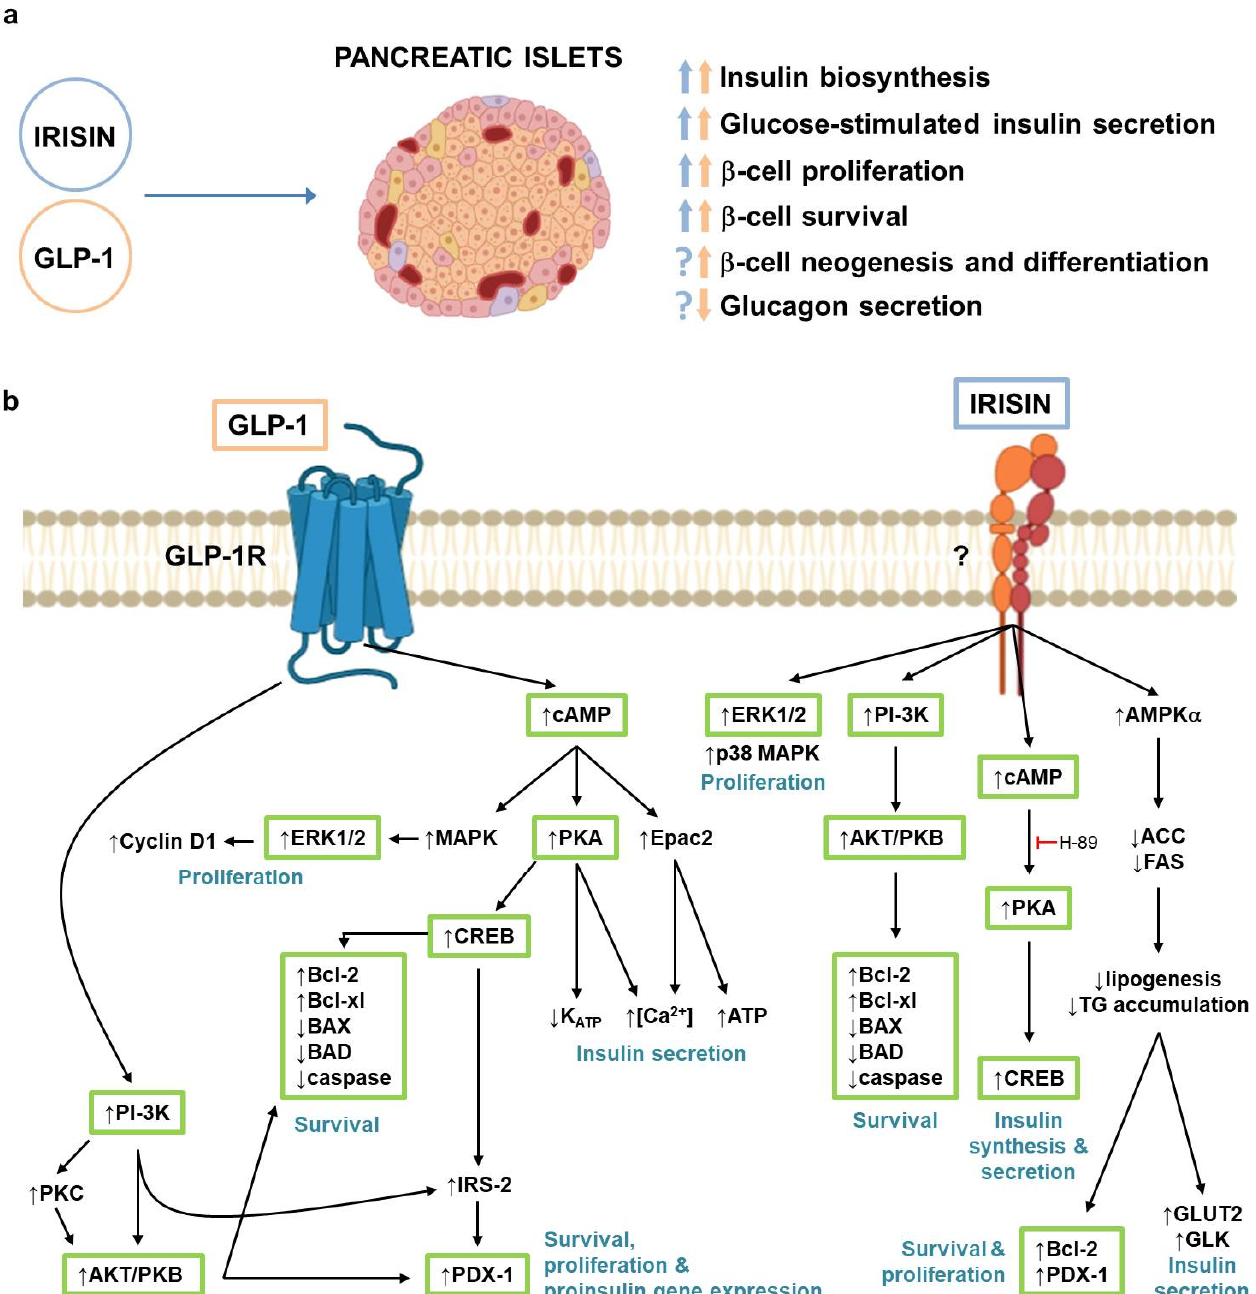
Figure 3. ( a ) GLP-1 and irisin effects in pancreatic islets. Blue arrows indicate irisin effects; orange arrows indicate GLP-1 effects; ( b ) Signaling pathways activated by GLP-1 and irisin in pancreatic β -cells. Green boxes indicate intracellular mediators activated by both GLP-1 and irisin. ACC, Acetyl-CoA carboxylase; AMPK α , adenosine monophosphate-activated protein kinase α ; AKT/PKB, protein kinase B; BAD, Bcl-2 associated agonist of cell death; BAX, Bcl-2-like protein 4; Bcl-2, B-cell lymphoma-2; Bcl-xl, B-cell lymphoma-xl; cAMP, cyclic adenosine monophosphate; CREB, cAMP response element-binding protein; Epac2, exchange protein activated by cAMP 2; ERK1/2, extracellular signal-regulated kinases 1/2; FAS, GLK, glucokinase; GLP-1, glucagon-like peptide-1; GLP-1R, glucagon-like peptide-1 receptor; GLUT2, glucose transporter 2; IRS-2, insulin receptor substrate 2; MAPK, mitogen-activated protein kinase; PDX-1, pancreatic and duodenal homeobox 1; PI-3K, phospatidylinositol-3 kinase; PKA, protein kinase A; PKC, protein kinase C; TG, triglycerides. GLP-1 stimulates insulin secretion by intervening in nearly all steps involved in the exocytosis of insulin secretory granules (i.e., ATP synthesis, inhibition of potassium-ATP